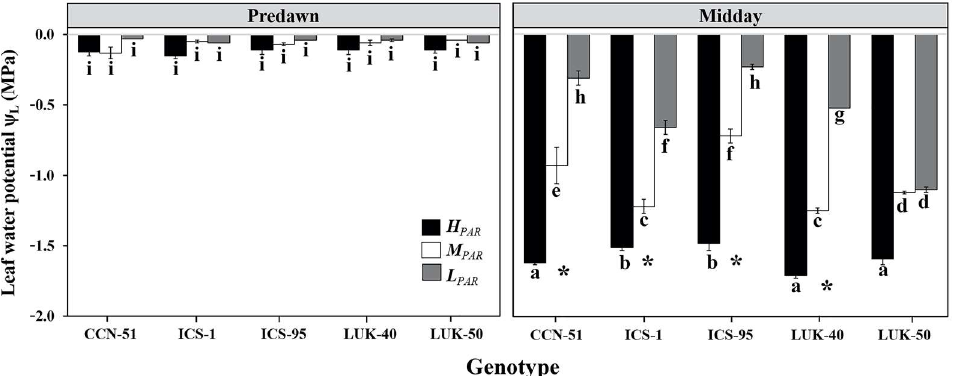
Figure 1. The leaf water potential ( Ψ L ; MPa) at predawn and midday for five genotypes of cacao in three levels of radiation considered were high mean daily incident photosynthetically active radiation (H PAR , 2100 ± 46 mol m − 2 s − 1 ) that was in full sun, medium mean daily incident photosynthetically active radiation (M PAR , 1150 ± 42 mol m − 2 s − 1 ) and low mean daily incident photosynthetically active radiation (L PAR , 636 ± 40 mol m − 2 s − 1 ). a,b,c : Values in bars with different letters indicate significant differences between genotypes of cacao × radiation level (post hoc LSD Fisher, p < 0.05). *: Means statistical differences between radiation levels in each cocoa genotype. The results include means ± SE ( n = 4).